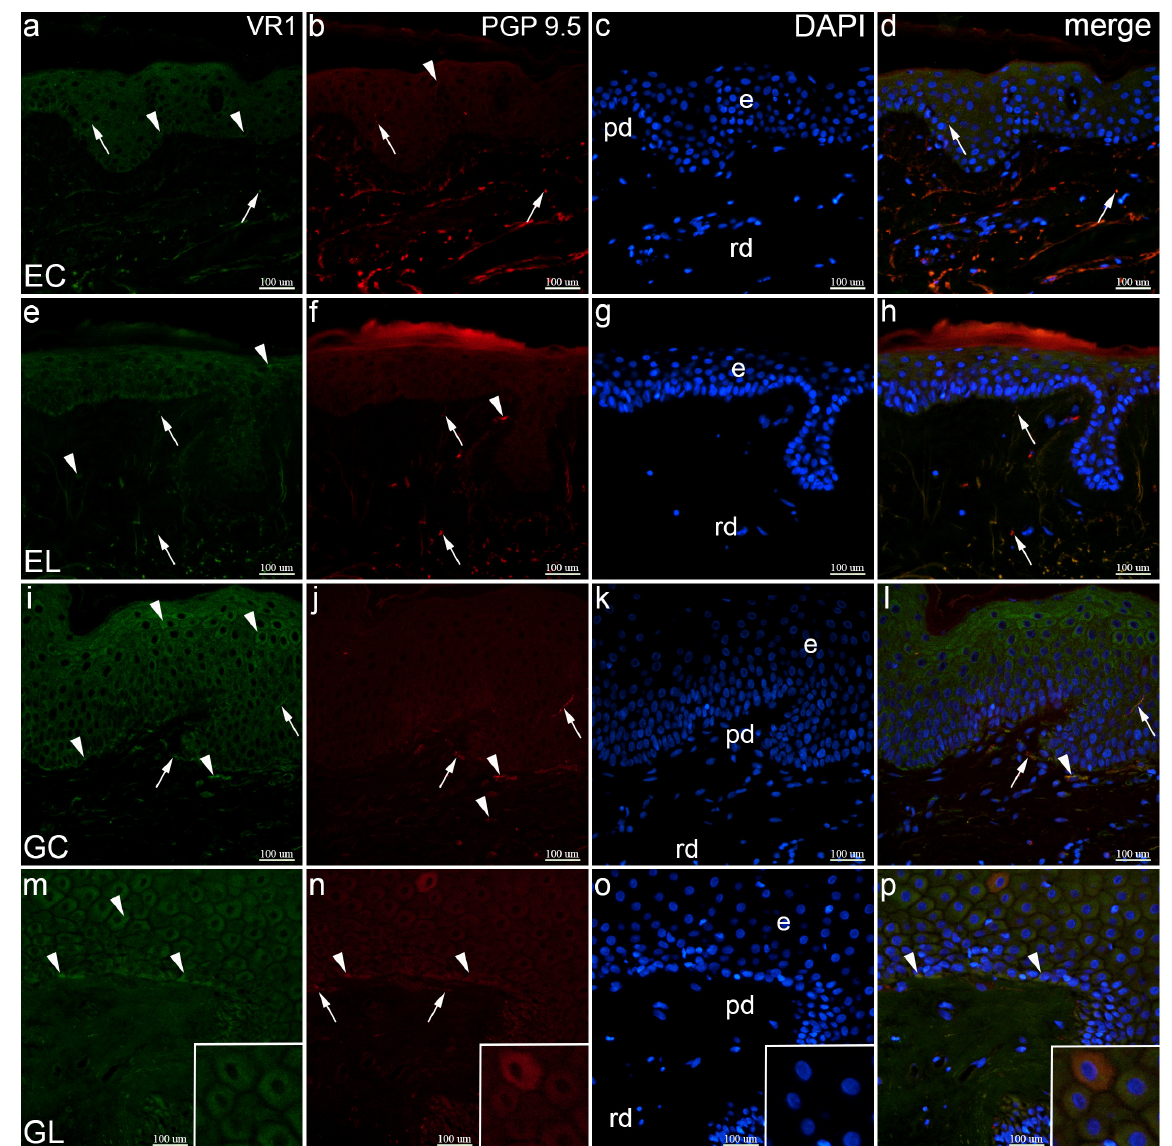
Figure 3. Co-expression of VR1 and PGP 9.5 in normal skin and lichen sclerosus skin samples. The epidermis (e), papillary dermis (pd), and reticular dermis (rd) are marked on DAPI staining images which display all cell nuclei ( c , g , k , o ). EC—normal extragenital skin ( a – d ): keratinocytes (arrowheads) and nerve fibers (arrows) display VR1 expression ( a ); keratinocytes (arrowhead) and nerve fibers (arrows) also express PGP 9.5 ( b ); VR1 and PGP 9.5 are co-expressed in nerve fibers (arrows, ( d )). EL—extragenital skin affected by lichen sclerosus ( e – h ): keratinocytes and some dermal cells (arrowheads) as well as nerve fibers (arrows) show VR1 expression ( e ); dermal cells (arrowhead) and nerve fibers (arrows) are PGP 9.5-positive ( f ); VR1 and PGP 9.5 are co-expressed in nerve fibers (arrows, ( h )). GC—normal vulvar skin ( i – l ): keratinocytes and some dermal cells (arrowheads), and nerve fibers (arrows) show VR1 expression ( i ); dermal cells (arrowheads) and nerve fibers (arrows) also express PGP 9.5 ( j ); nerve fibers (arrows) and a dermal cell (arrowhead) display VR1 and PGP 9.5 co-expression ( l ). GL—vulvar skin affected by lichen sclerosus ( m – p ): VR1 is expressed in keratinocytes (arrowheads, ( m )); keratinocytes (arrowheads) and nerve fibers (arrows) express PGP 9.5 ( n ); co-expression of VR1 and PGP 9.5 is seen in keratinocytes (arrowheads, ( p )); insets display VR1 expression ( m ) and strong PGP 9.5 expression ( n ) which co-localize in a keratinocyte ( p ). Double immunofluorescence staining to VR1, PGP 9.5 and DAPI, × 400